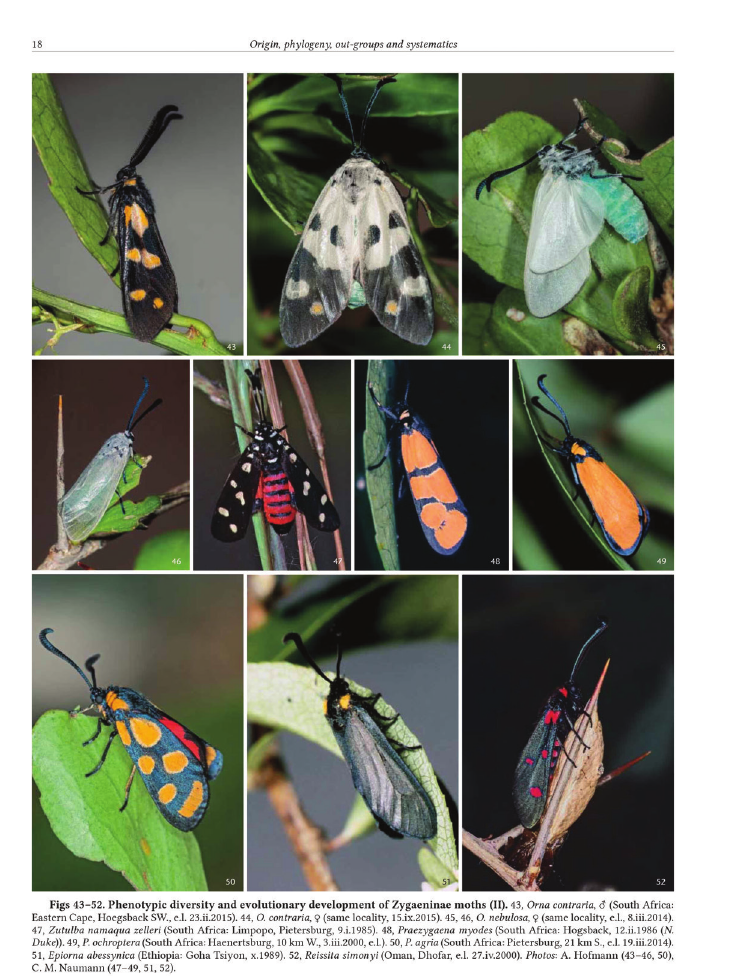
Figure 2. Phenotypic diversity in burnet moths on page 18 of the